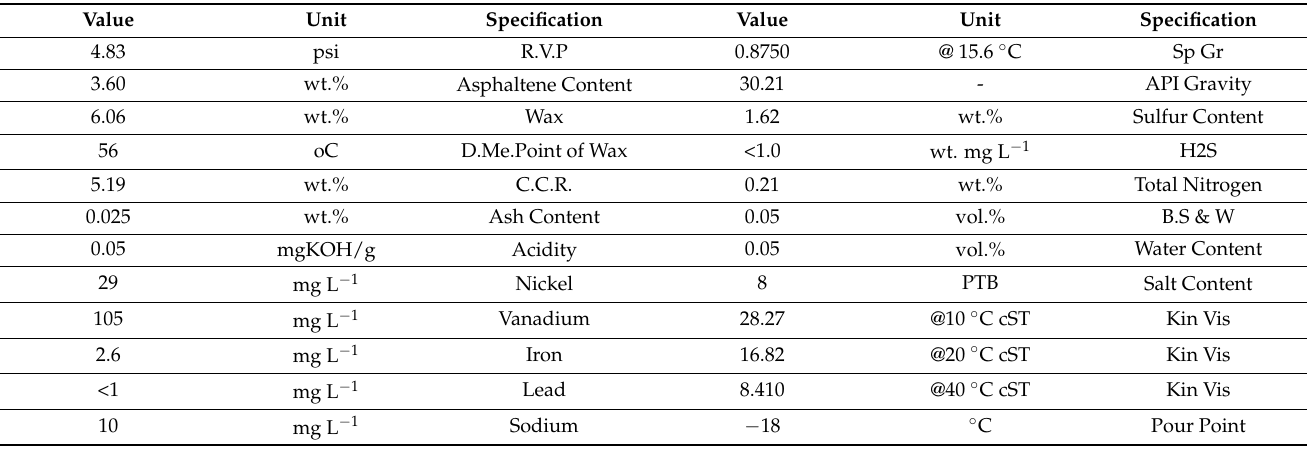
Table 3. Analyses of crude oil’s properties, both physical and chemical used for preparing synthetic wastewater of desalter